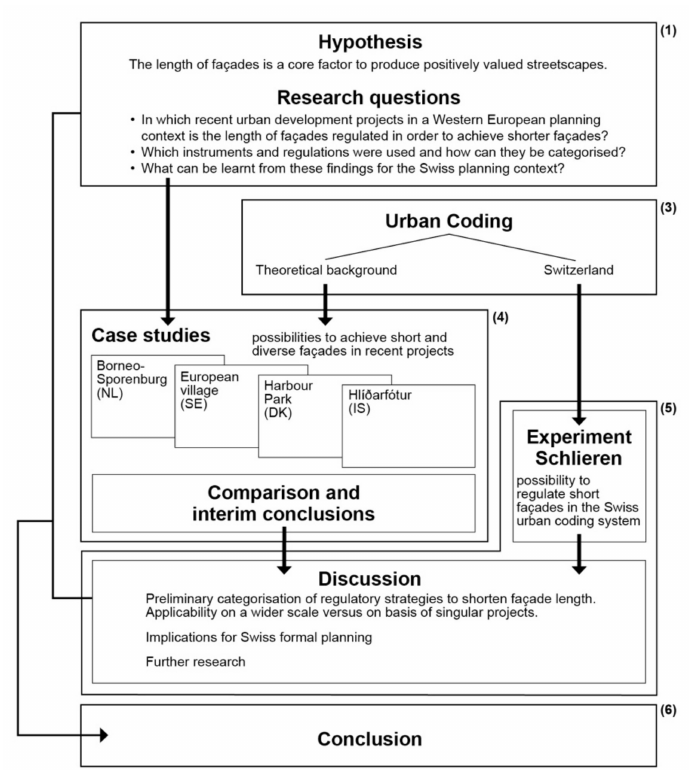
Figure 4. Research schema (with reference to sections of this paper). Source: